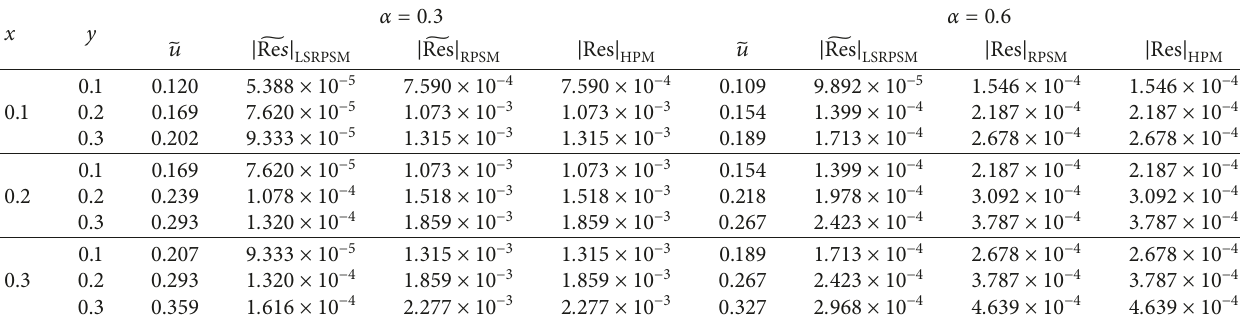
Figure 6: Approximate solution: (a) 􏽥 u ( x, t, α � 0 . 3 ) ; (b) 􏽥 u ( x,t, α � 0 . 5 ) ; (c) 􏽥 u ( x, t, α � 0 . 7 ) ; (d) 􏽥 u ( x,t, α � 0 . 9 ) . Table 6: The values of | 􏽦 Res ( x, t )| by LSRPSM, RPSM, and HPM for α � 0 . 3 , 0 . 6 and t � 0 .